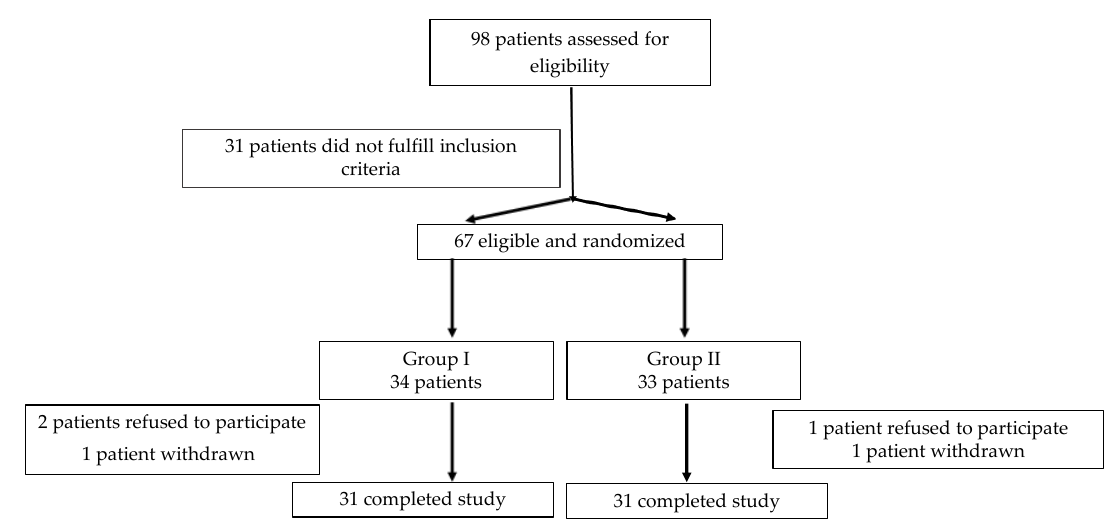
Figure 1. Flowchart showing patient randomization and disposition.